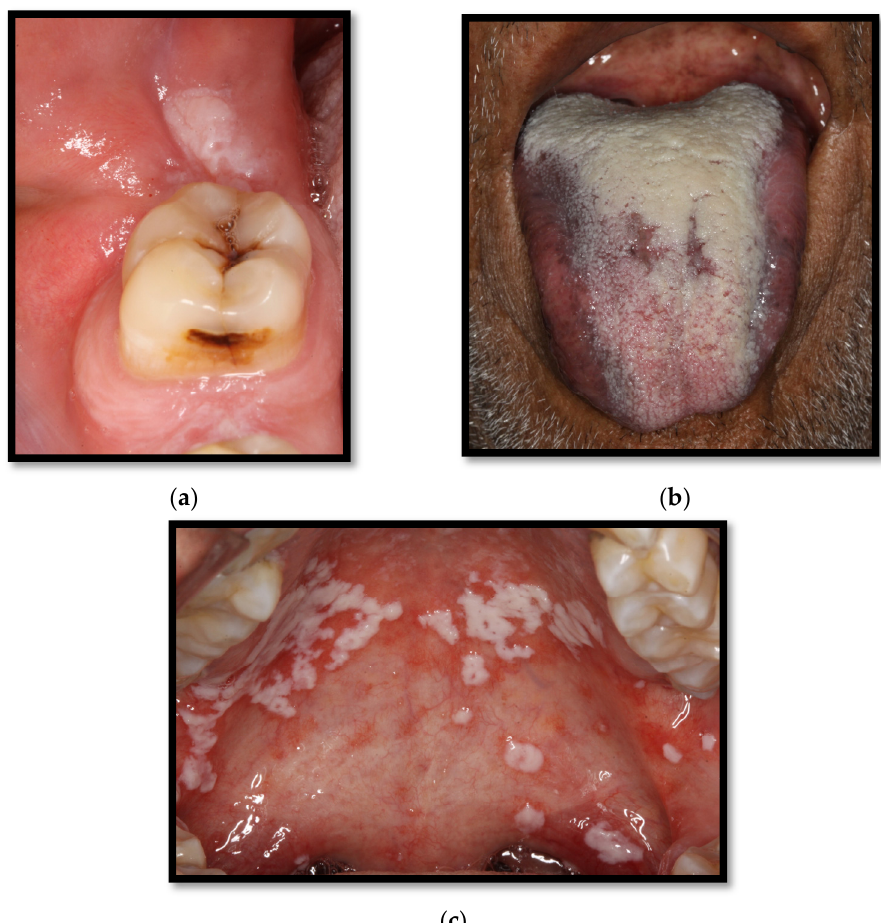
Figure 1. ( a ) Pseudomembranous candidiasis in the retromolar region; ( b ) pseudomembranous candida on the dorsum of the tongue; ( c ) pseudomembranous and erythematous candidiasis on the hard and soft palate.